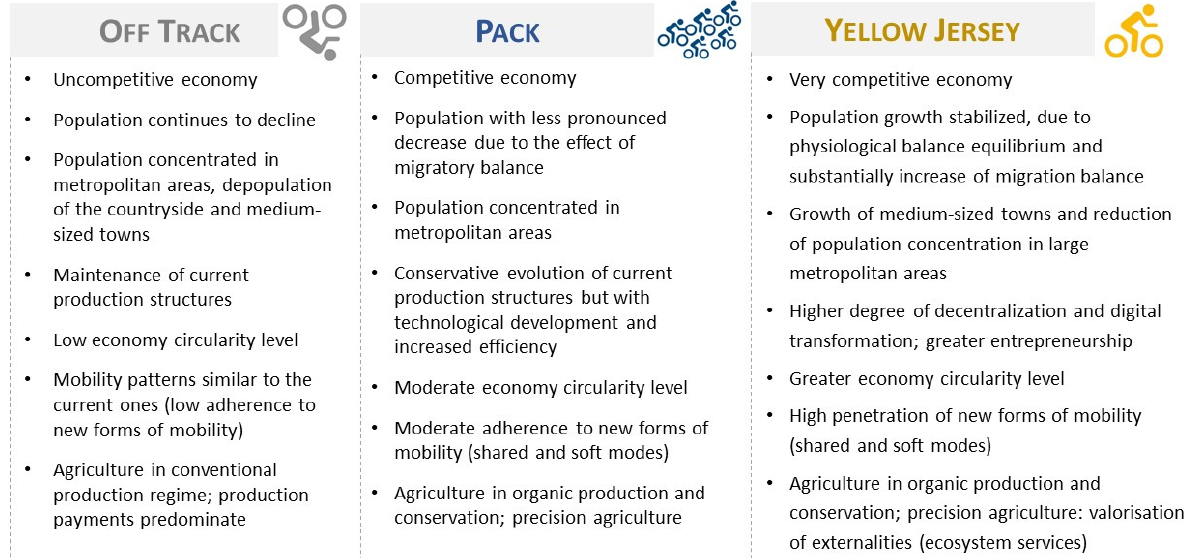
Figure 2. Narratives underlying the three macroeconomic scenarios considered: Off Track, Pack, and Yellow Jersey.